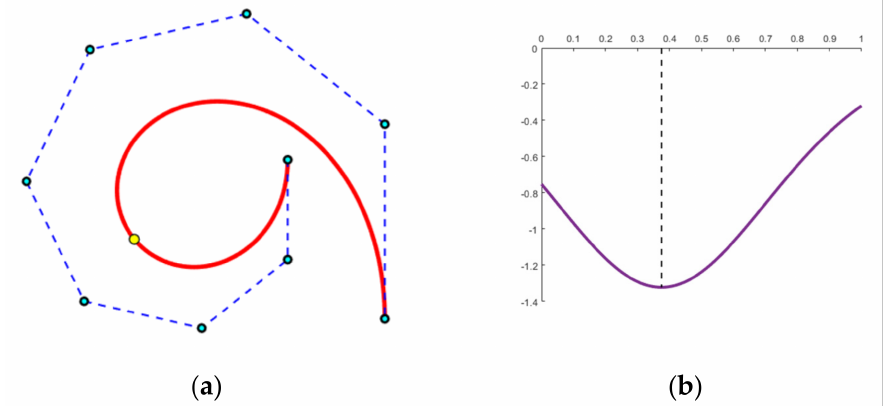
Figure 11. Typical B é zier curve with degree k = 8 for s · cos θ < 1 ( s ≥ 1). ( a ) Transformation (cid:32) (cid:33) cos ( − 2 π /7 ) − sin ( − 2 π /7 ) matrix M = 1.1 · ; point with curvature extremum is represented sin ( − 2 π /7 ) cos ( − 2 π /7 ) by yellow dot; ( b ) curvature plot has a minimum at t ∗ = 0.3747.